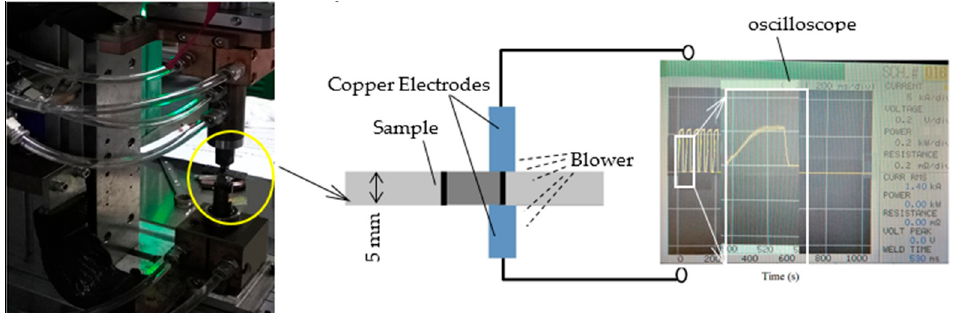
Figure 5. EPT test